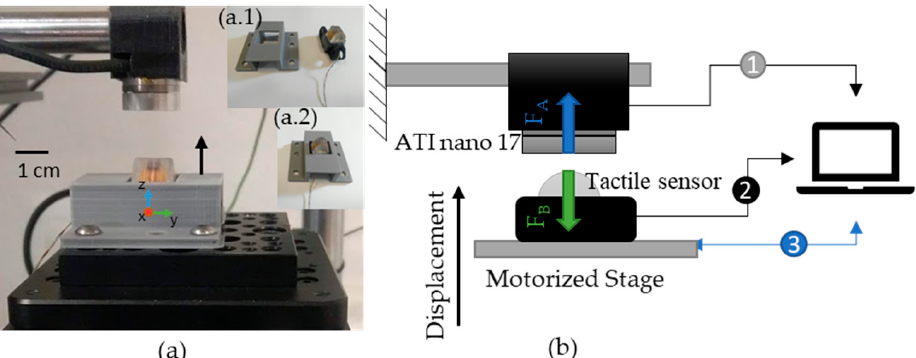
Figure 12. ( a ) The aluminum rod in a cantilever configuration, the ATI nano 17, the magnetic tactile sensor, and the stage; ( a.1 ) shows a 3D printed part (left) to fix the tactile sensor (right) to the stage; ( a.2 ) shows how the 3D printed part fits with the tactile sensor. ( b ) Force equilibrium and working principles of the setup, where the identifies data from the ATI nano 17 ( (cid:1832) (cid:3051) , (cid:1832) (cid:3052) , (cid:1832) (cid:3053) , (cid:1846) (cid:3051) , (cid:1846) (cid:3052) and (cid:1846) (cid:3053) ) , the data from both L-00 and R-11 lateral FPCS of the eight sensors (L1–R4) and the data from the PC to the three servo motors Thorlabs stage controlling the displacement.